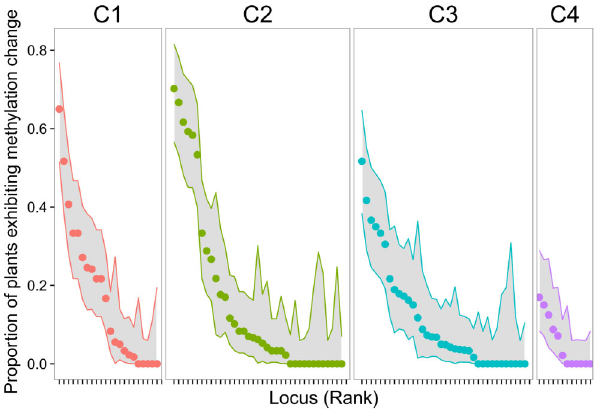
Figure 3. Epigenetic changes from individual sporophytes to descendant gametophytes. Scatterplot of Helleborus foetidus sporophyte and gametophyte samples on the common multilocus space defined by nonmetric multidimensional scaling axes (MDS1 and MDS2) from the pairwise epigenetic distance matrix for sporophytes and gametophytes combined into a single sample. Only data for the N =29 loci whose methylation status differed significantly between sites for either sporophytes ( N =24) or gametophytes ( N =20) in single-locus analyses were included in the analysis. Each arrow connects the positions of the sporophyte (base) and its descendant gametophyte (tip), color-coded according to sampling site (NAV, TEJ and PLL). Note that this plot is not strictly comparable to the two plots in Fig. 1, as the latter are based on separate, independent analyses for sporophyte and gametophyte samples using the whole set of